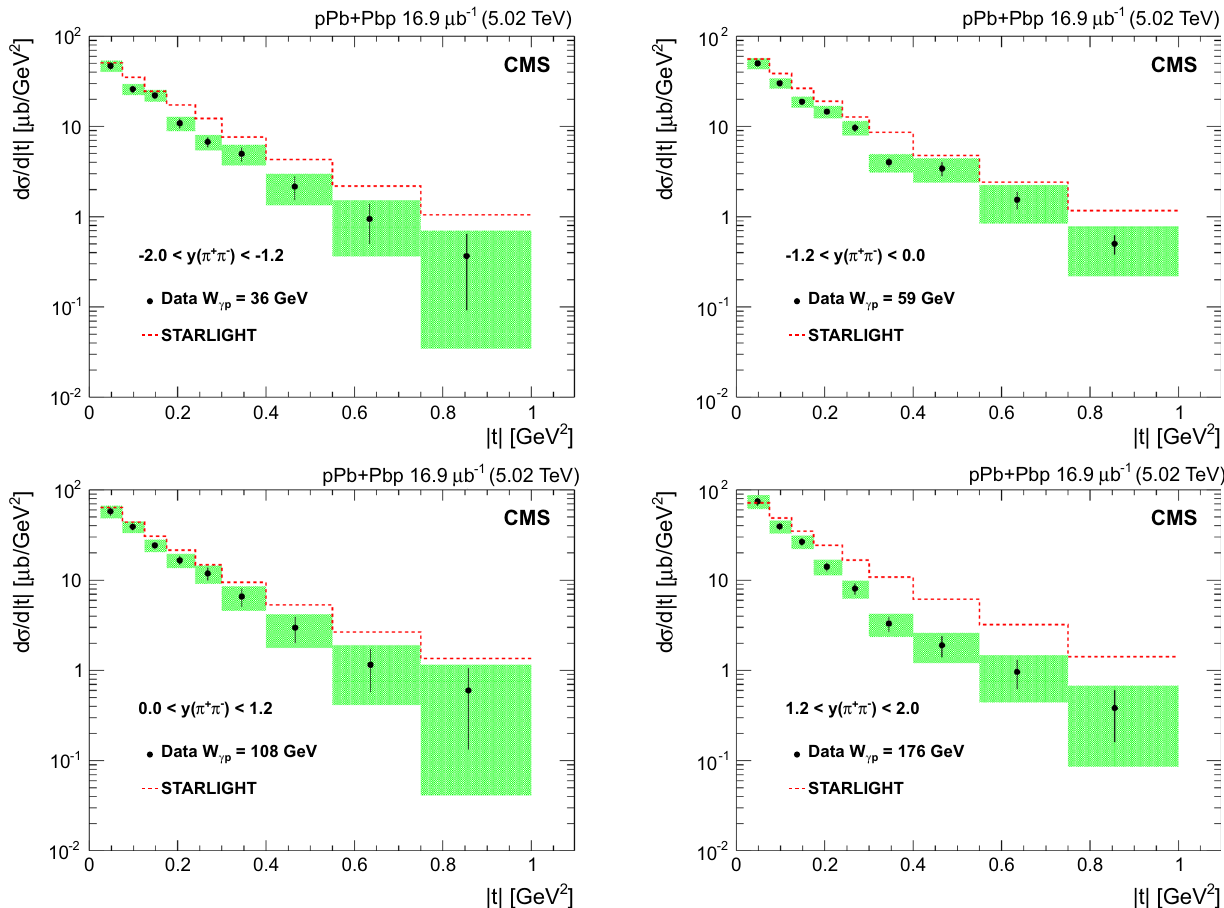
Fig. 5 Differential cross section d σ/ d | t | (full circles) in four different rapidity bins. The error bars show the statistical uncertainty, whereas the shaded areas represent the statistical and systematic uncertainties